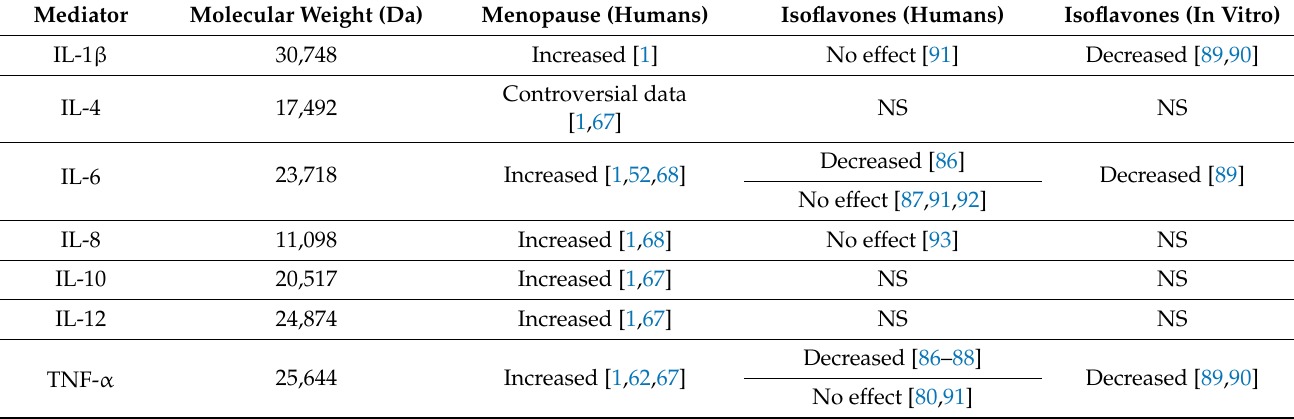
Table 3. Inflammatory molecule actions in menopausal women and in vitro experiments after isoflavones use (NS: not studied).